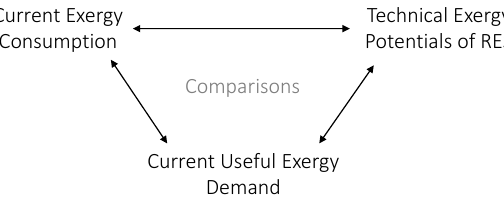
Figure 6. Overview of all comparisons, which are discussed in this paper, visualized by arrows.